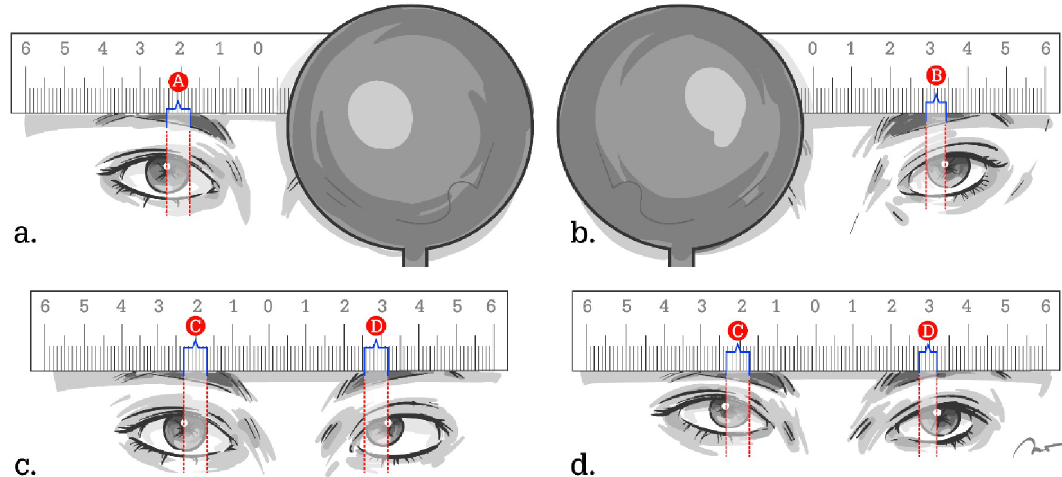
Fig 1. The photographic method. (a) Right eye fixing to a central target, and left eye occluded, A is the distance from the CLR to nasal corneal limbus. (b) Left eye fixing to a central target, and right eye occluded, B is the distance from the CLR to nasal corneal limbus. (c) Both eyes open, and right eye fixating on a central target, C is the distance from the right CLR to nasal corneal limbus. The distance from the left CLR to nasal corneal limbus is D. (d) Both eyes open, and left eye fixating on a central target. (The above illustrations are the original works of the